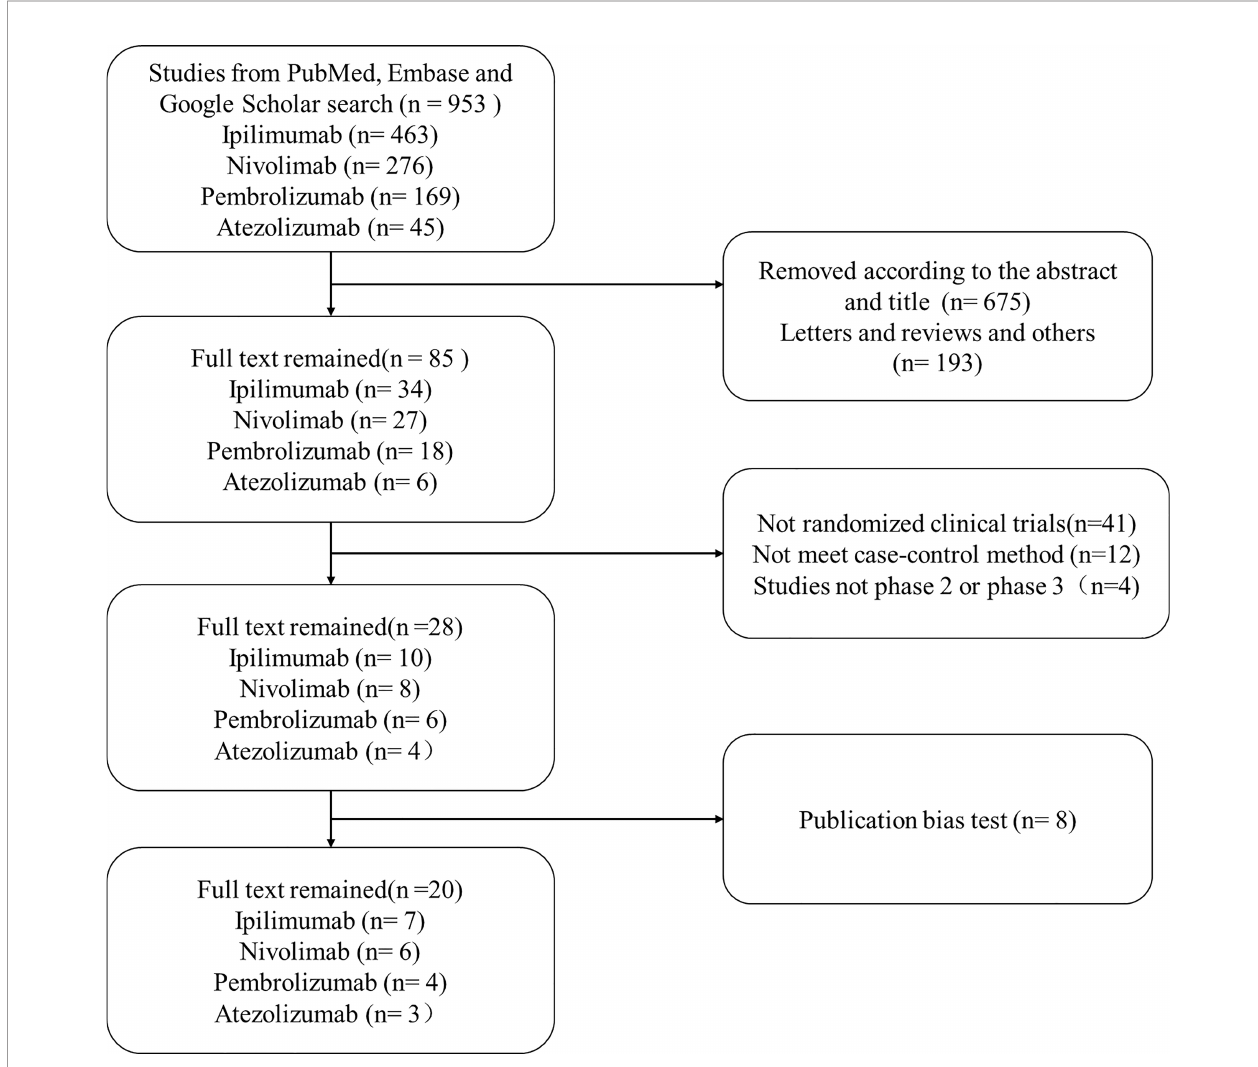
FIGURE 1 | The fl owchart of collecting articles. Through the search strategy, a total of 953 articles were identi fi ed. According to the title and abstract, 675 articles were primarily deleted, 193 articles were removed because they were letters, reviews, and other articles, 41 articles were excluded as they were non-randomized clinical trials, 12 articles were removed because they did not meet our case – control method, and 4 articles were deleted because studies were not phase 2 or phase 3 RCTs. Then 28 were remained. Moreover, 8 articles were removed after the publication bias